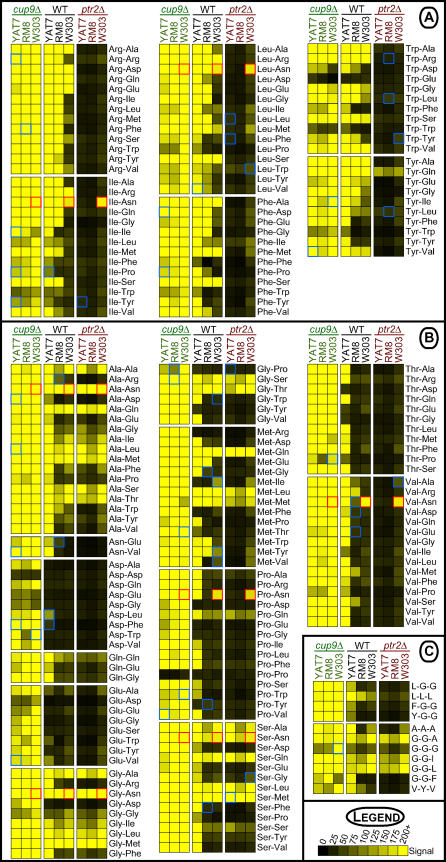
Deletion of CUP9 and PTR2 Strongly Impacts Di/Tripeptide Utilization in S. cerevisiae StrainsElimination of the PTR2 repressor Cup9p revealed that Ptr2p can facilitate the utilization of nearly all di/tripeptides tested in the PM assay, yet Ptr2p was not required for the utilization of a subset of di/tripeptides as a nitrogen source. See Figure 2 for a detailed explanation of the yellow boxes and colored borders.(A) N-end rule dipeptides, (B) non–N-end rule dipeptides, and (C) tripeptides; amino acids are represented as single letters.